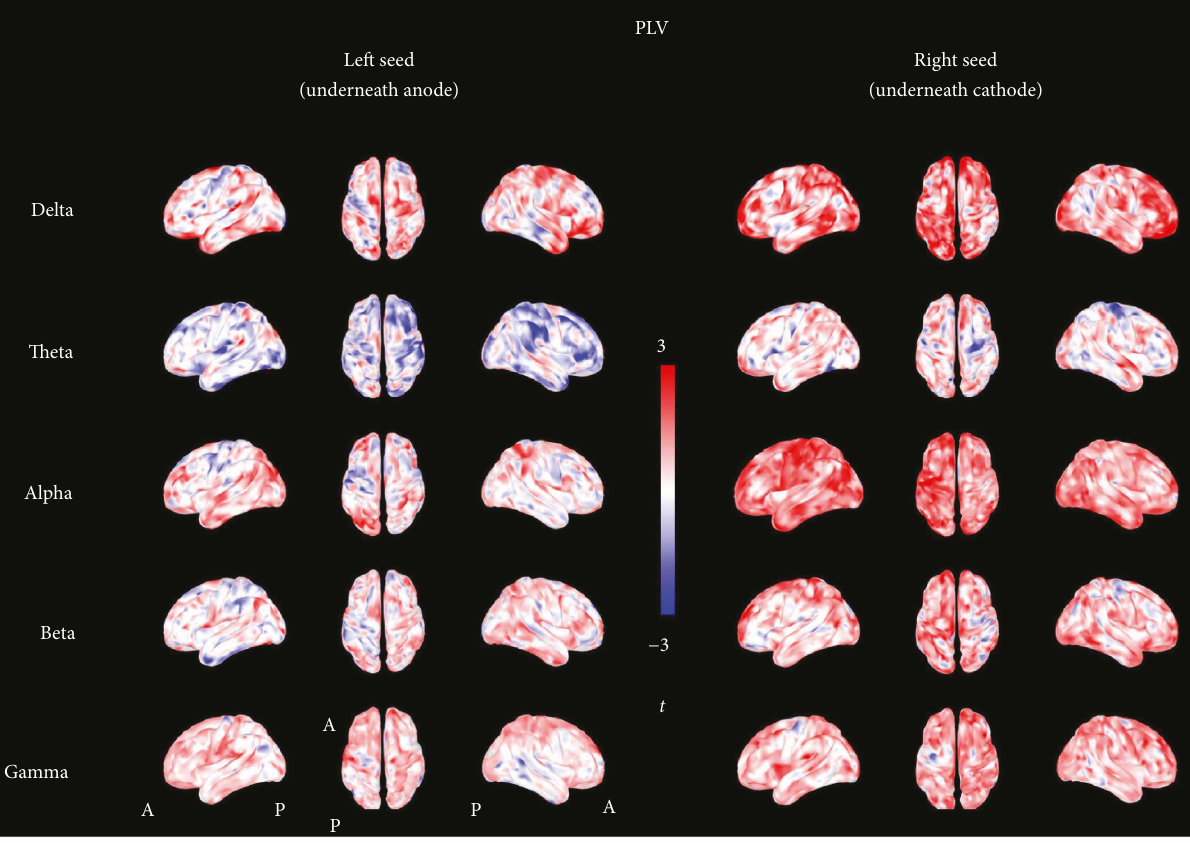
Figure 5: t -maps of resting-state connectivity (PLV). The fi gure shows the topographic distribution of t -values calculated for the phase locking value. Shades of red colors indicate positive values, shades of blue colors indicate negative values, and shades of white indicate values toward zero. An inspection of these maps shows a widespread increment of PLV values in all frequency